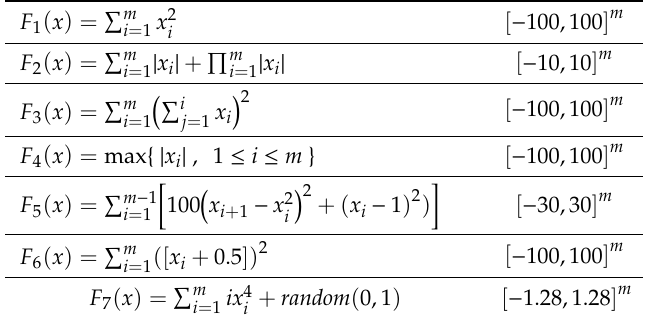
Table A1. Unimodal objective functions.